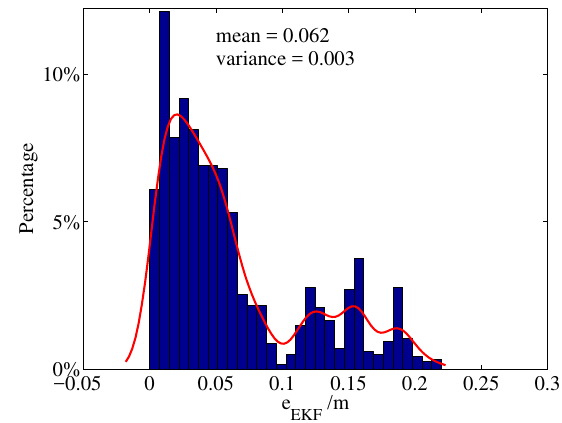
Figure 16. Distribution of EKF localization errors (Euclidean norm).